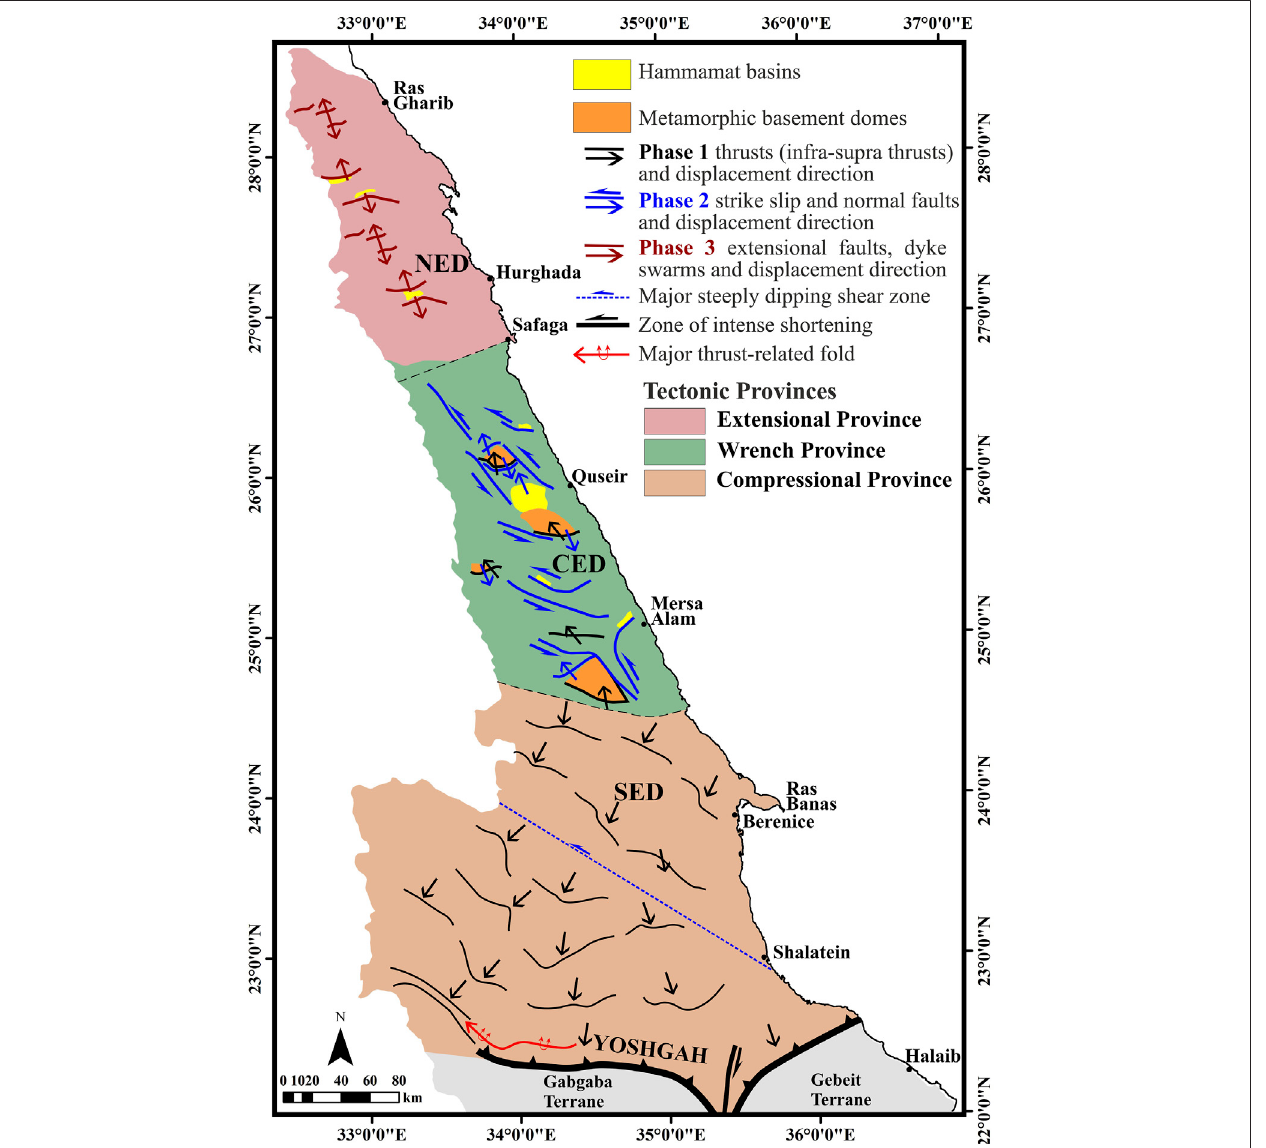
FIGURE 8 | Tectonic map showing structures separated according to the age and occurrences in different tectonic provinces.